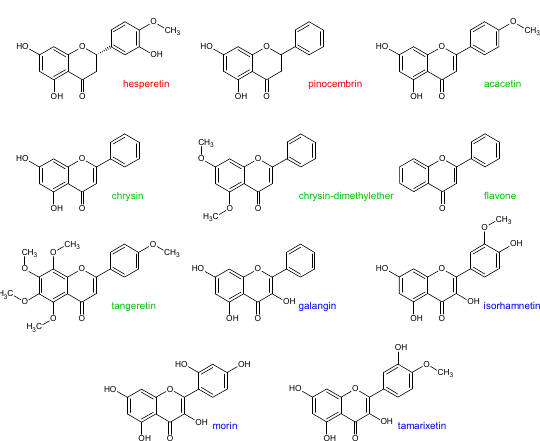
Figure 1. Structural characteristics of flavonoids used in this study. Flavanones are marked in red, flavones in green, and flavanols in blue.